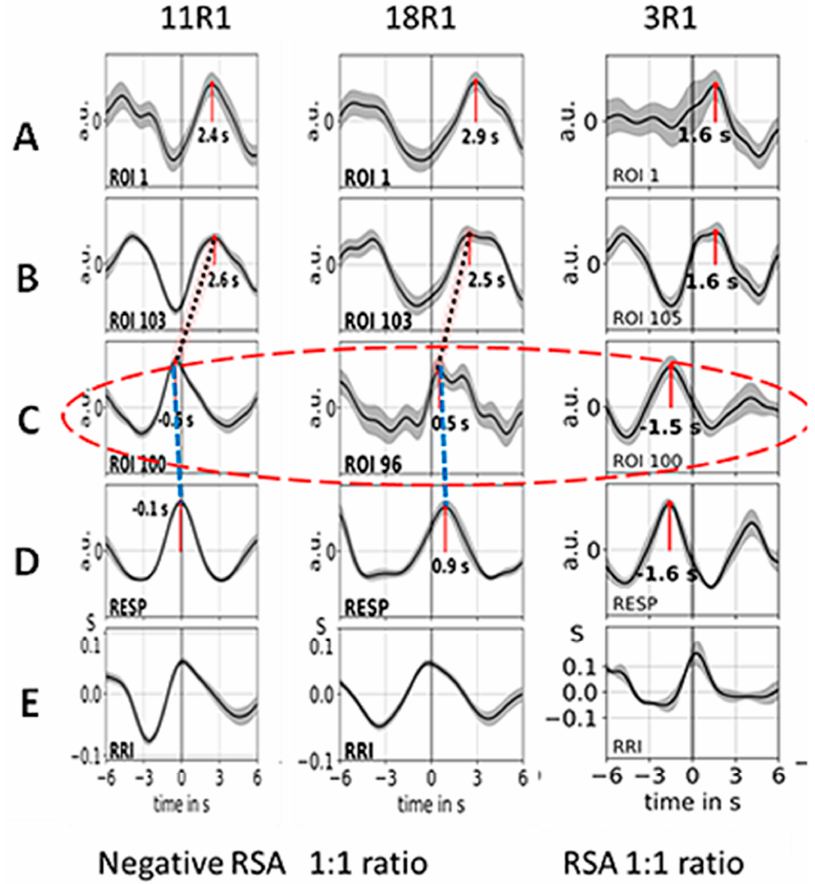
Figure 2. Examples of ~10 averaged BOLD ( A – C ), respiration ( D ) and RRI ( E )-peak-triggered waves (mean ± SEM) of the subjects of group 1 (#11, #18, #3). Time intervals are shown from 6 s before to 6 s after the trigger. Numbers indicate the time shift in seconds between the peak and trigger. The red ellipse marks respiratory motion artefacts of the BOLD signal. The time shifts between breathing (line D) and respiratory BOLD artefacts (ROIs 96, 100; line C) are indicated by blue stippled lines, and the time shifts between respiratory BOLD artefacts and associated neural BOLD waves (ROI 103, 105; line B) are indicated by red stippled lines (only in the first two columns). The coherent breathing and RRI waves (lines D and E) in the first two subjects (#11, #18) indicate negative RSA (nRSA) while the out-of-phase behavior of breathing and RRI waves in the third column (subject #3) is characteristic for classical (positive) RSA (modified from